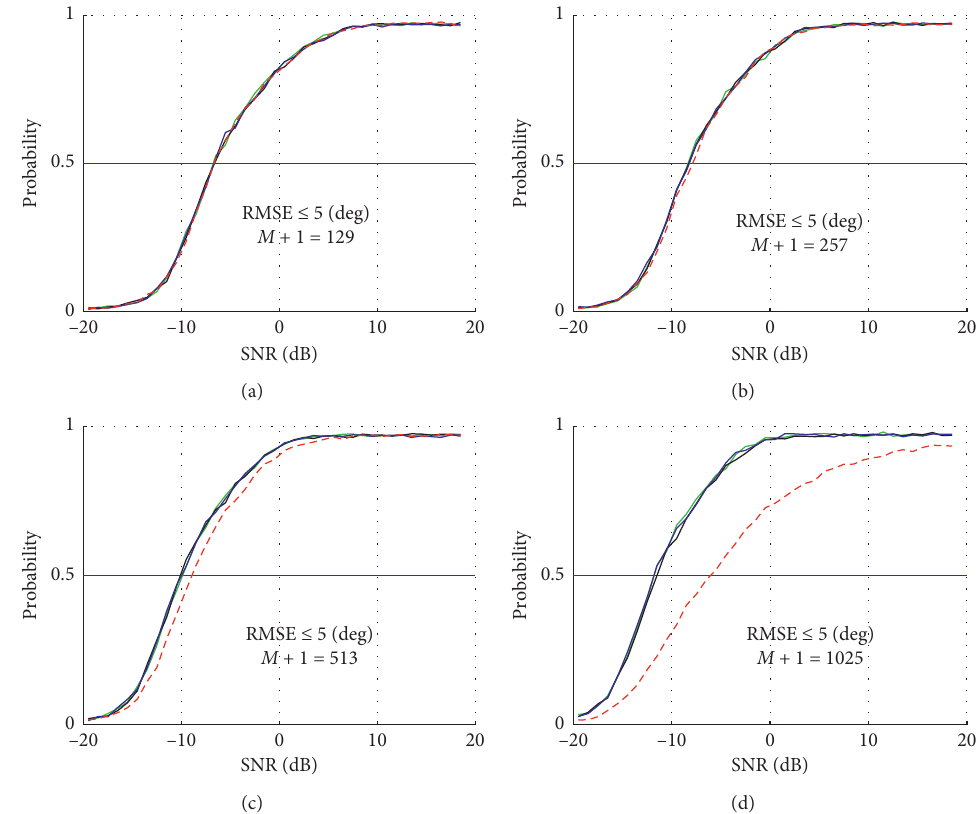
Figure 4: Probability of AoA measurement of Array-3, when RMSE ≤ 5 ° . Dashed line is WF-4